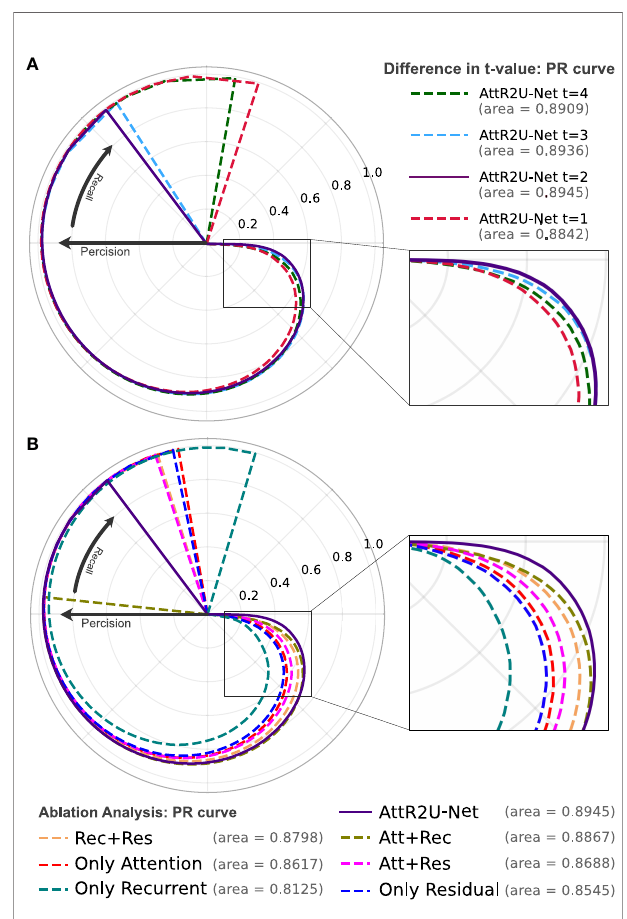
FIGURE 4 | (A) The PR curve of AttR2U-Net with t values of 1, 2, 3, and 4. (B) The PR curve of the ablation analysis experiment includes 7 models with different parts of AttR2U-Net. The PR curves use a form of the rose diagram to show the comparison results more visually. The area value refers to the area under the PR curve in a plane right-angle coordinate system, also known as AUC. From (A) , our model achieves the best performance when t is taken as 2. From (B) , our model has the largest AUC value and is at the outermost part of the rose